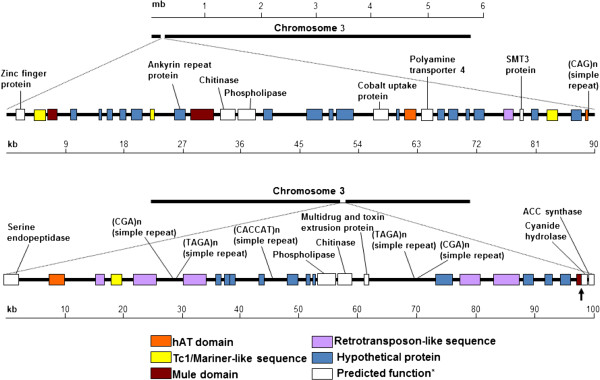
Genetic context of Class I and II transposable elements in VdLs.17. The sequence segments include 90 kb from supercontig 4 nucleotide positions 162,000-222,000 (top), and 100 kb from supercontig 8 nucleotide positions 1006000 – 1106000 (bottom), of chromosome 3. The arrow indicates the position of the putative cyanide hydratase fusion protein (VDAG_04885) containing both nitrilase and MULE transposase functional domains (pfam 00795 and 10551, respectively). *Predicted gene names were assigned by the Broad Institute (www.broadinstitute.org/annotation/genome/verticillium_dahliae).